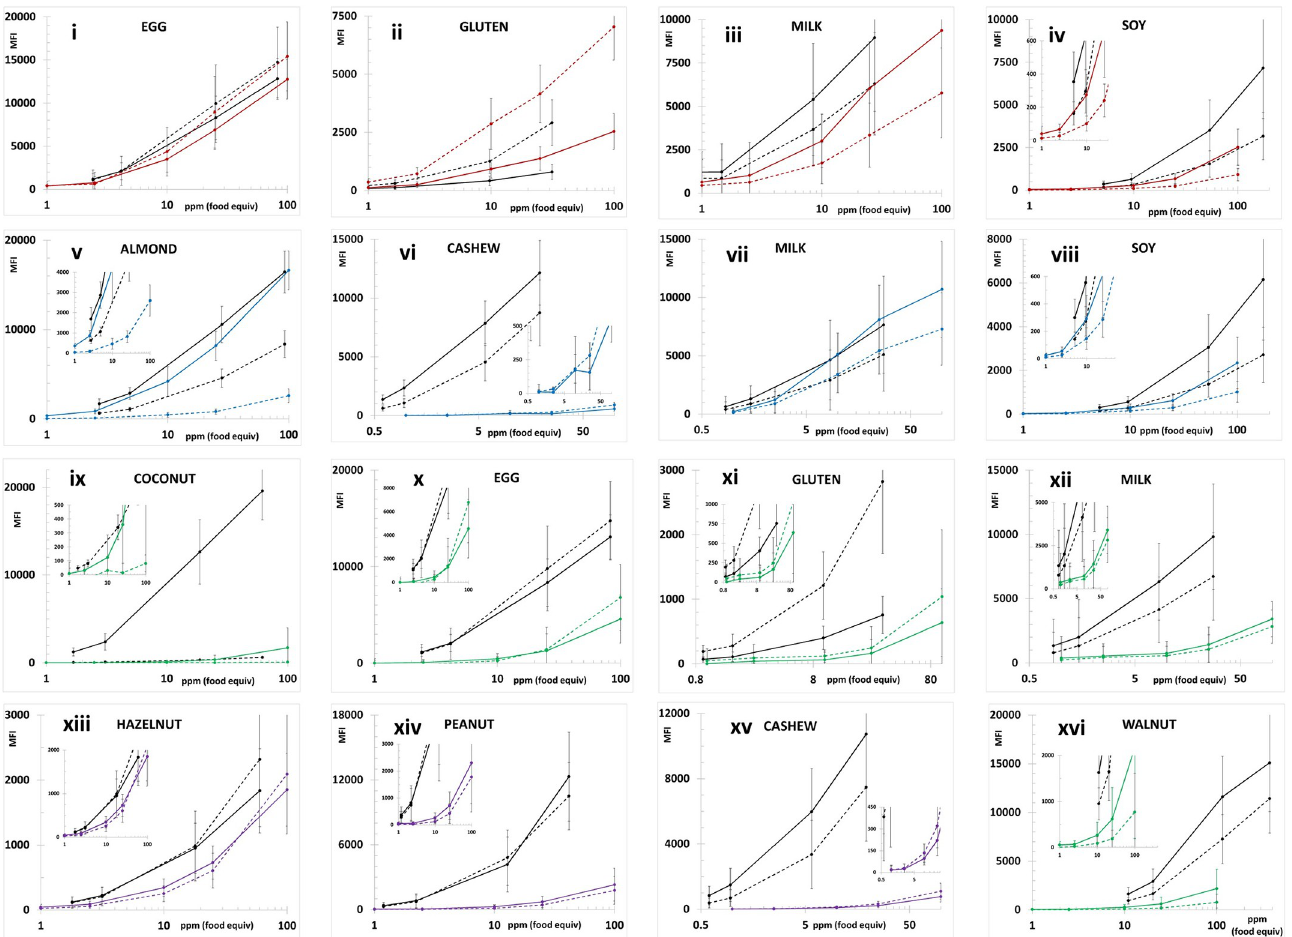
Fig 4. Average MFI across all 11 laboratories of bead sets generating MFI with incurred food samples. Plotted are the average of concurring positive bead set analyses, each performed in triplicate across all 11 laboratories. The colored lines are the data derived from the food samples ( red —meat, blue –orange juice, green –baked muffins, and purple –dark chocolate) and the black lines are the calibration standards ran concurrently. Solid lines indicate the lower numerical bead set (e.g., egg-25) and the dashed lines the higher (e.g., egg-26) of complementary pairs. Graphs i, ii, iii, iv depict the egg, gluten, milk, and soy bead set analyses of the meat samples; Graphs v, vi, vii, viii depict the almond, cashew, milk, and soy bead set analyses of the orange juice samples; Graphs ix, x, xi, xii, xvi depict the coconut, egg, gluten, milk, and walnut bead set analyses of the baked muffin samples; Graphs xiii, xiv, xv depict the hazelnut, peanut, and cashew bead set analyses of dark chocolate. The two cashew results are included despite the responses being ‘classical’ cross-reactivity with very low measurable MFI and the ratios inconsistent with cashew. The meat data entailed only the results from 10